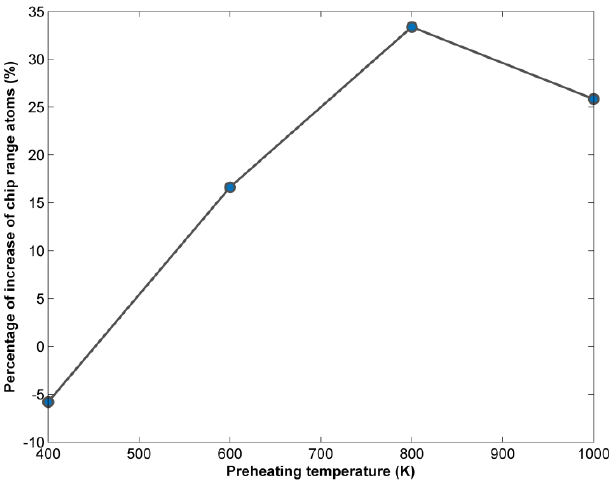
Figure 9. Variation of chip range atoms percentage of increase with respect to preheating tempera- ture.